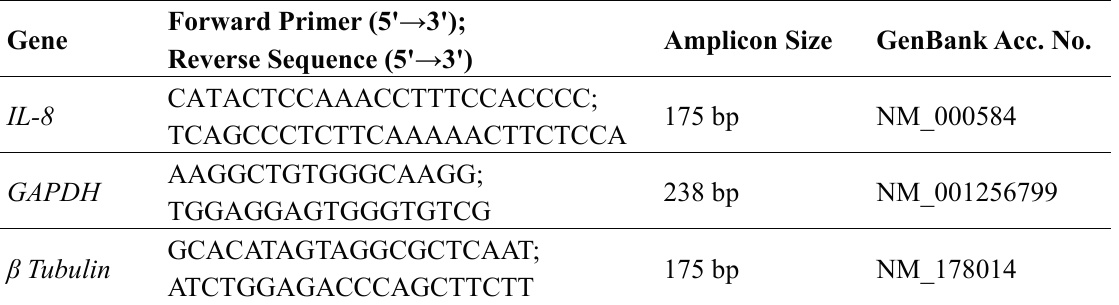
Table 4. Primers for the